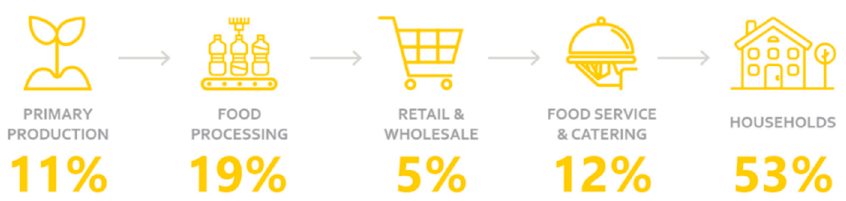
Figure 1. Food loss and food waste throughout the value chain (source: active and intelligent packaging in relation to food waste [12]).